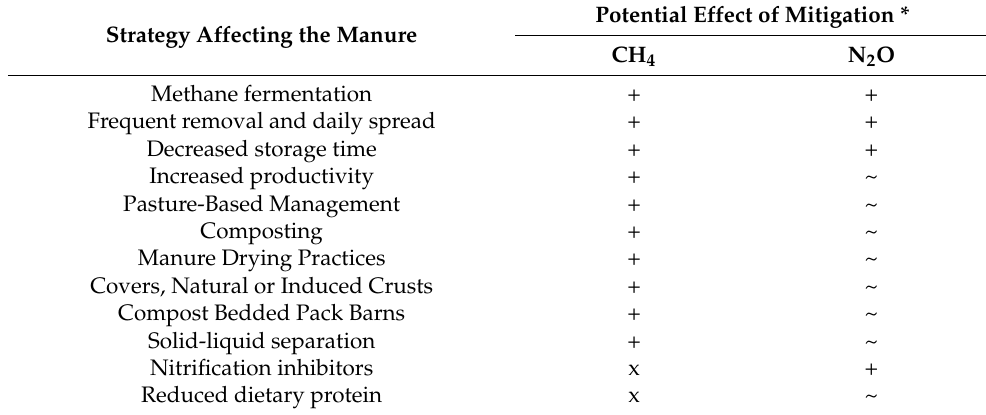
Table 11. Methane and missions reduction on potential of various strategies of the manure affecting (based on [6,27] and MilKey + MELS projects